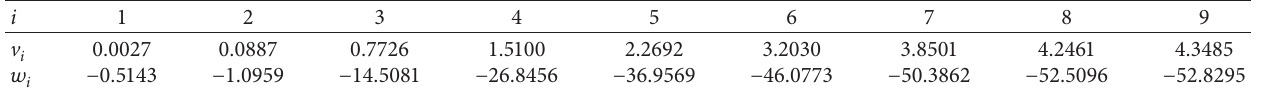
Figure 22: Input signals for nonlinear identification of the Peltier process. (a) Signal for estimation. (b) Signal for validation. Table 8: Summary of WH-EA parameter settings for nonlinear identification of the thermal process. Parameter Description Value MaxGen Generations number Minimum distance between two points Table 9: Nonlinearity coordinates ( n � 9 ) estimated by WH-EA from thermal process.